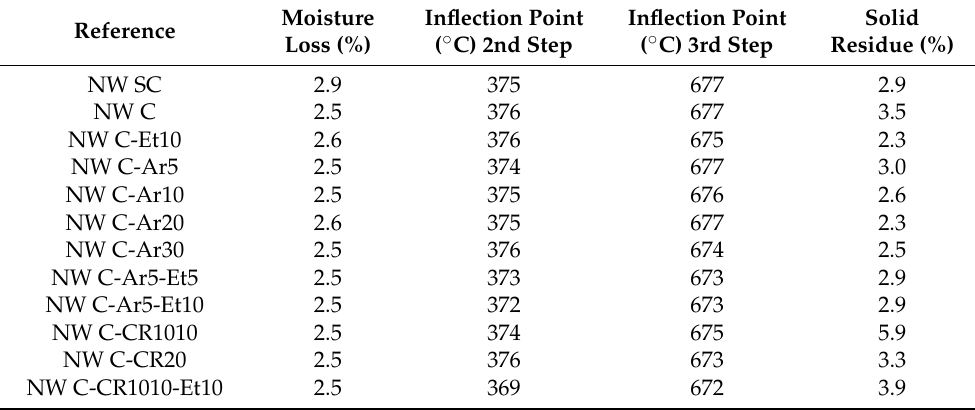
Table 4. Thermogravimetric analysis (TGA) results for the